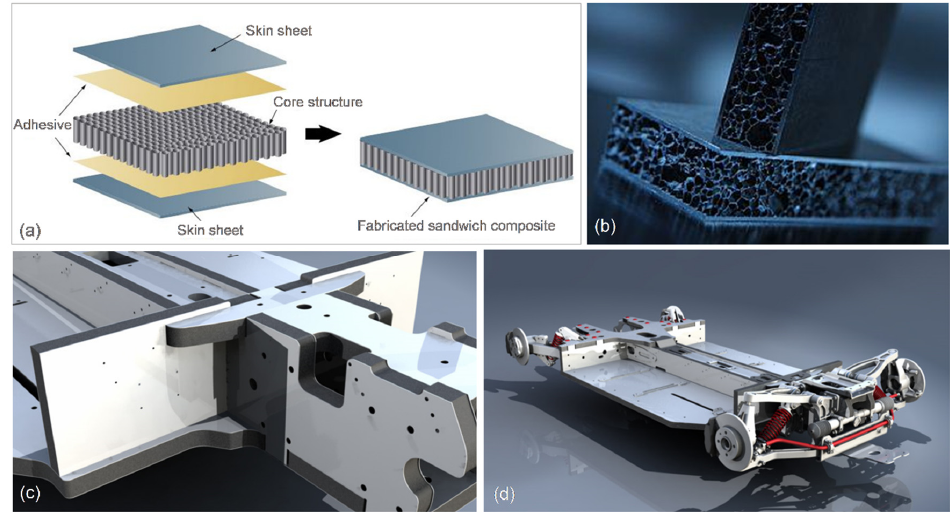
Figure 17. Sandwich ‐ structured composites: ( a ) schematics showing elements of the sandwich structure [105]; ( b ) alumi ‐ Figure 17. Sandwich-structured composites: ( a ) schematics showing elements of the sandwich num foam sandwich [105]; and ( c , d ) concept of applying the lightweight aluminum and ARPRO propylene ‐ based foam structure [105]; ( b ) aluminum foam sandwich [105]; and ( c , d ) concept of applying the sandwich material in a car (Inrekor, UK) [110].